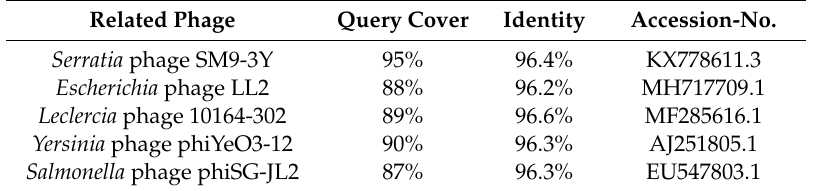
Table 1. Genome wide nucleotide identity of SALSA with the five most closely related phages.